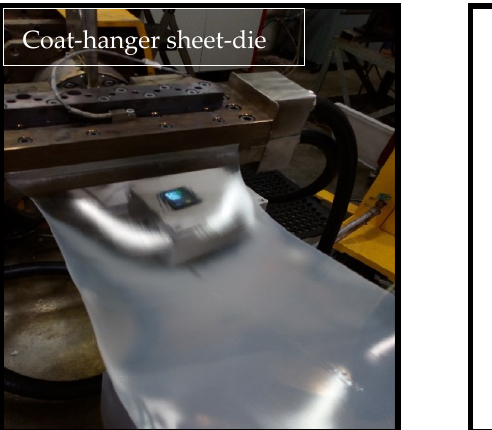
Figure 1. ( a ) The PP/MAPP sheet extrusion using a Labtech twin-screw extruder. ( b ) Schematic rep- resentation of reduction of sheet thickness in a hot press.